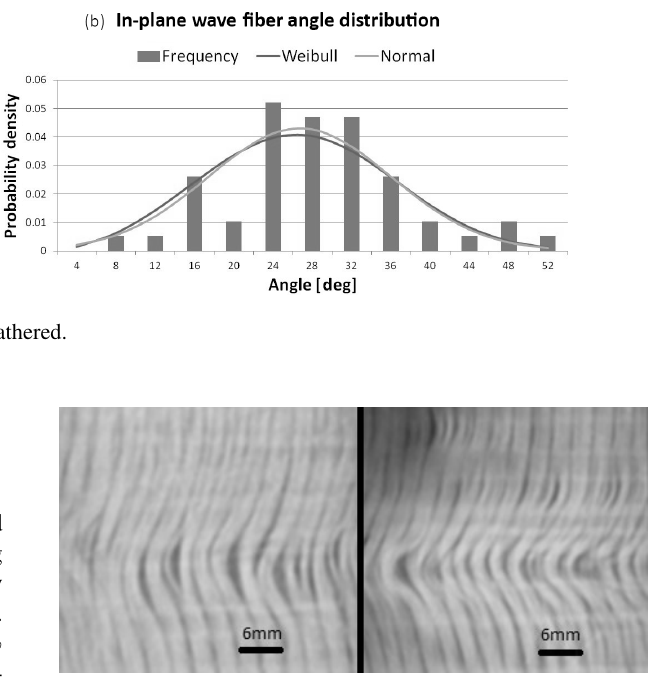
Figure 6. Radiographic images of IP waves found on different lay- ers of one specimen.